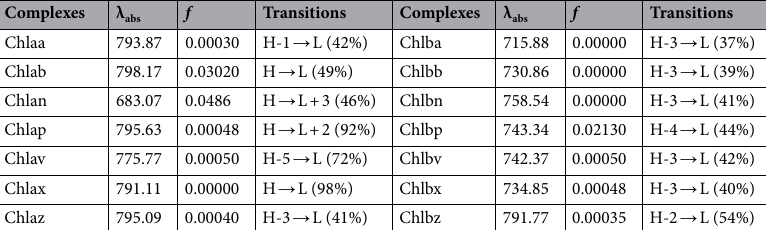
Table 5. Absorption wavelength (nm) (Triplet states), Oscillatory strength and transitions for Chla-carotenoid and Chlb-carotenoid complexes with wB97xD/Lanl2dz:6-31G** method by TDDFT in solvent (water)